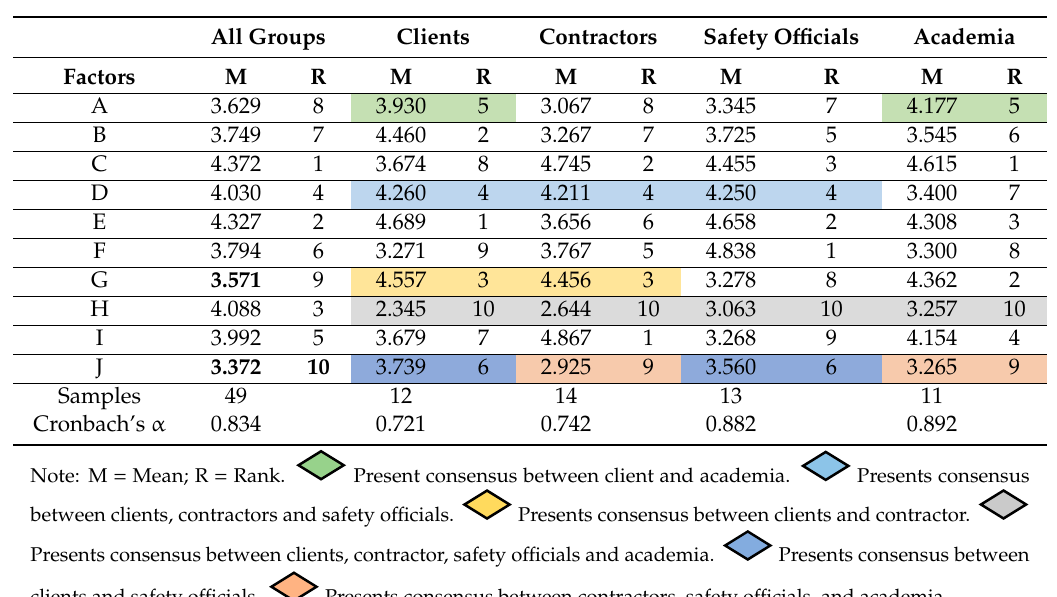
Table 5. Second Round of Delphi Survey.